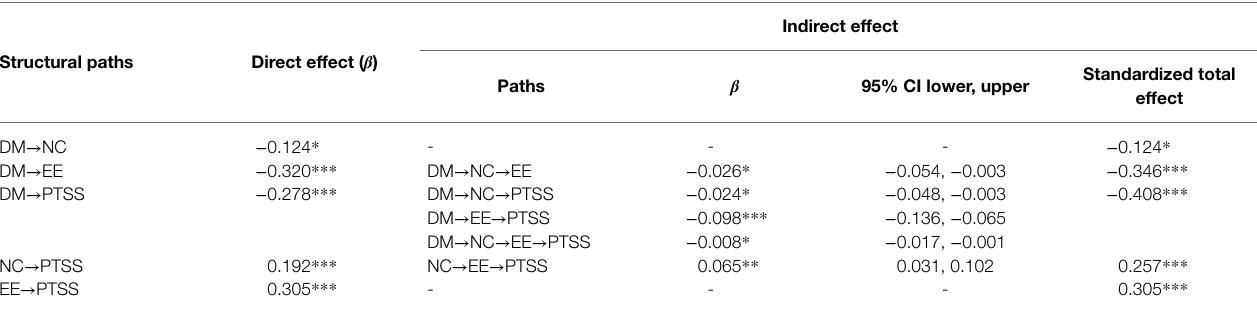
TABLE 2 | Effect estimates of the modified